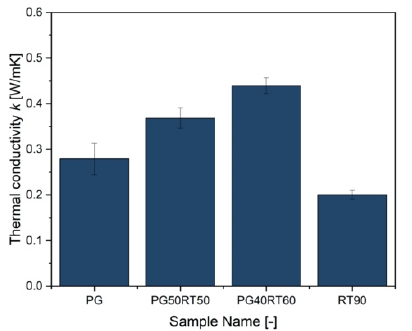
Figure 2. Average thermal conductivity of CPCMs and PG versus temperature after 96 cycles from 25 to 100 °C.